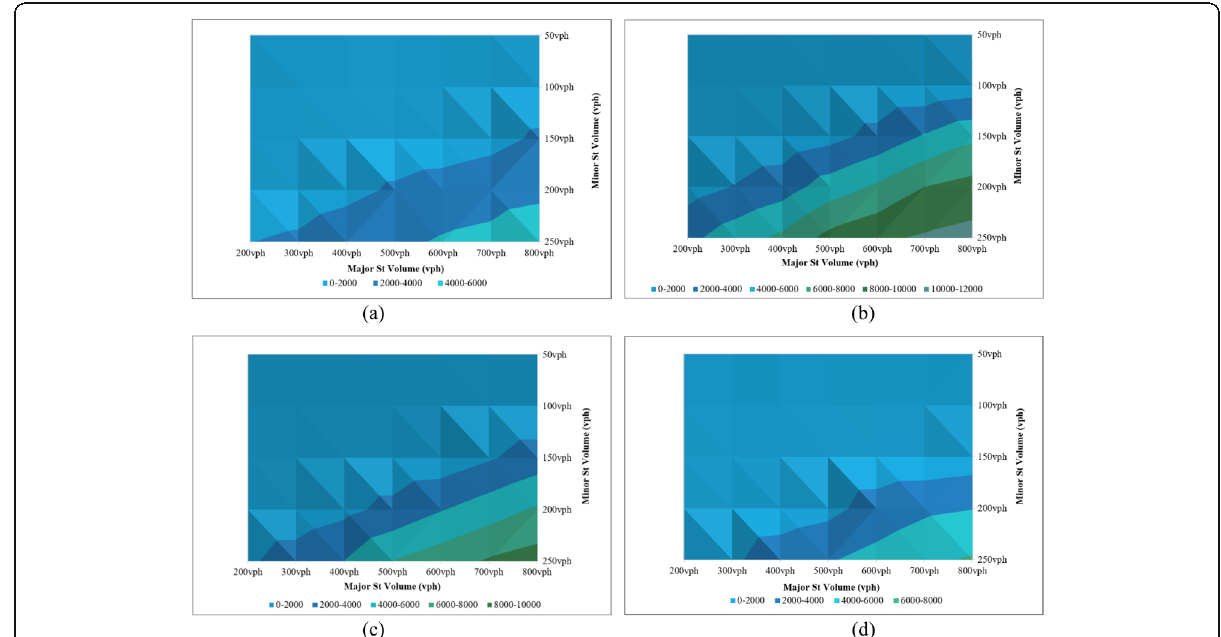
Fig. 4 Simulated Number of Conflicts at Mill Street under Various Demand Scenarios: a Free Signal Operation; b 80-s Coordination Plan; c 100-s Coordination Plan; d 130-s Coordination